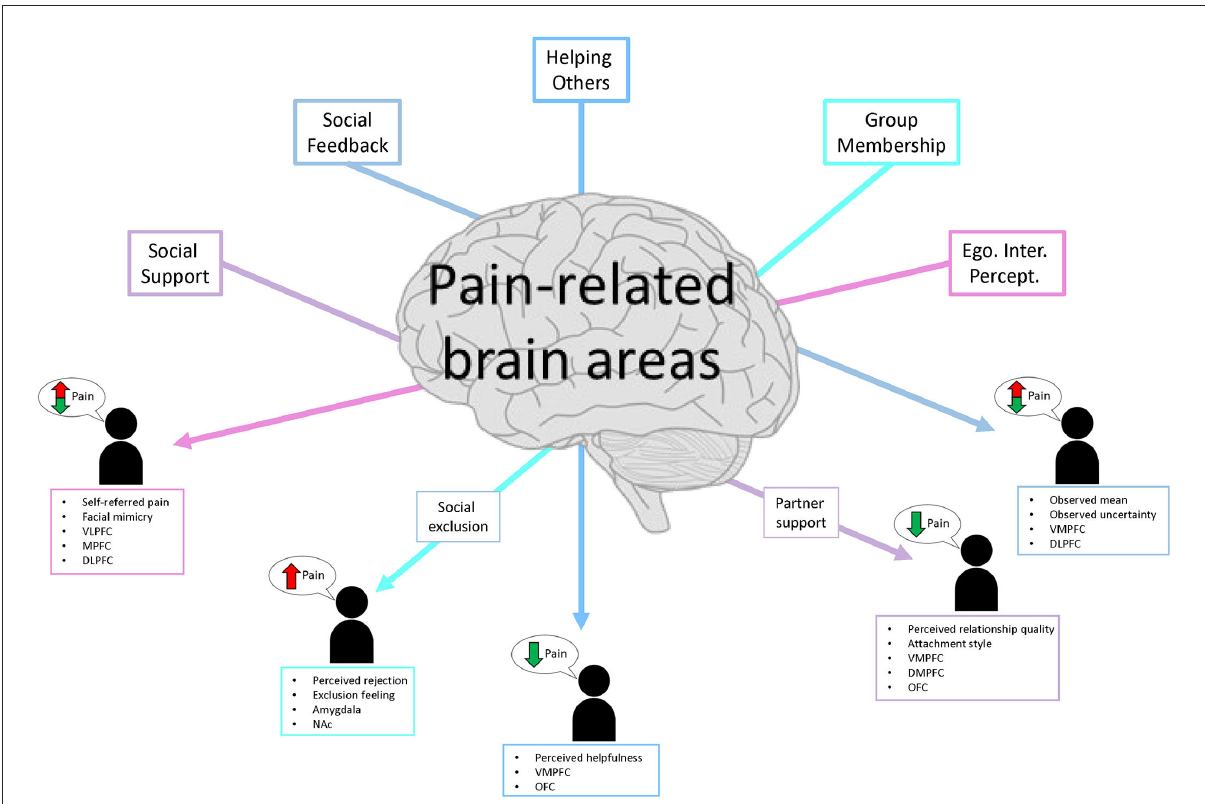
FIGURE2 Sketch summary of the five social themes, the direction of their influence on pain ratings, and the main modulatory/mediating brain